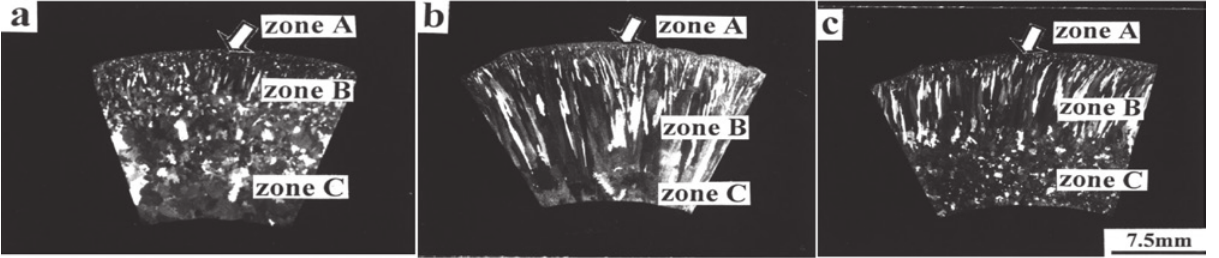
Fig. 3: Macrostructures on the cross-sections of the centrifugally cast 25Cr20Ni heat-resistant steel tubes: (a) typical centrifugal solidification, (b) centrifugal solidification with increased cooling rate and (c) centrifugal solidification with increased electromagnetic field. (Zone A = chill zone, zone B = columnar grain zone and zone C = equiaxed grain zone)